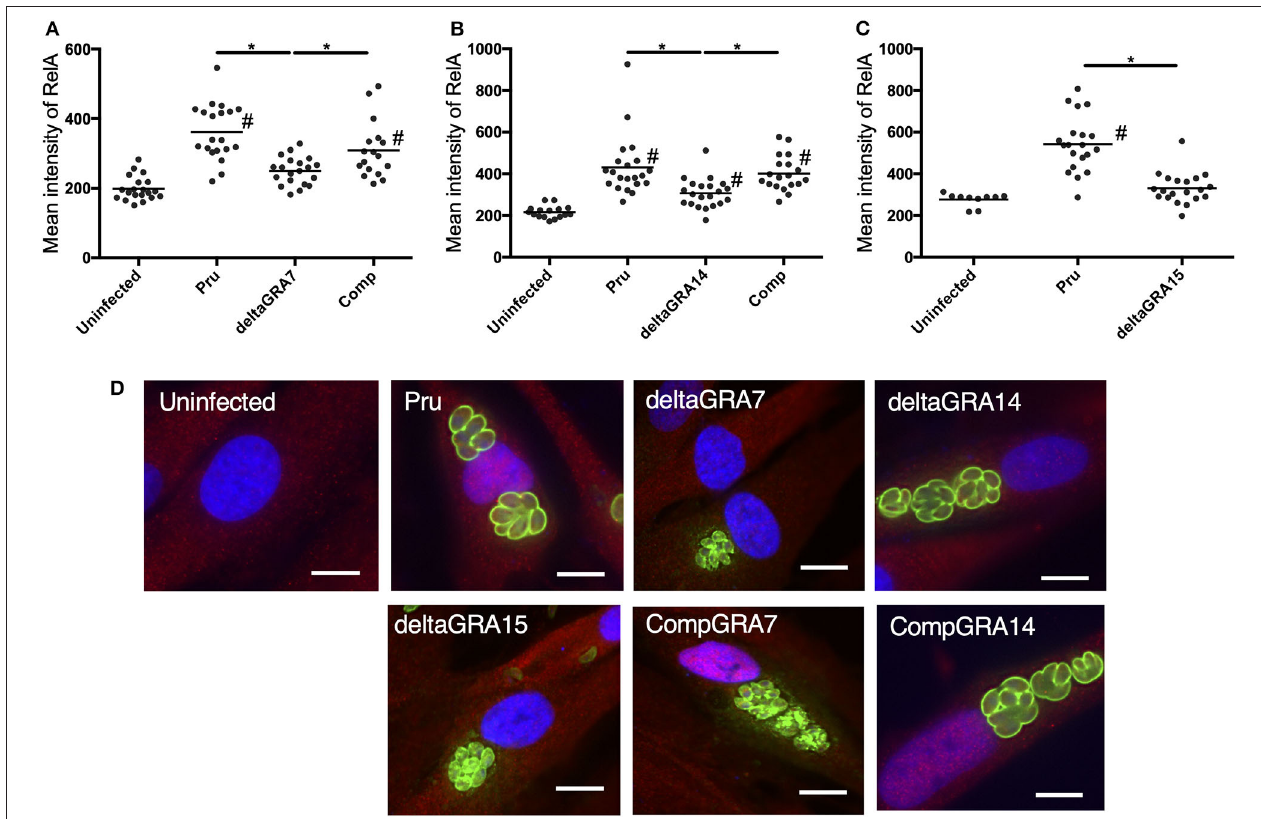
FIGURE 3 | T. gondii infection with parasites deficient in GRA7, 14, or 15 decreases nuclear translocation of NF κ B RelA in HFF cells. (A–C) The mean intensity of RelA in the nucleus was measured in HFF cells for each group. Experiments were performed twice. Bar indicates the mean of each group, * p < 0.05. #a significantly higher level of nuclear RelA compared with uninfected cells ( p < 0.05). Differences were tested by one-way ANOVA with turkey’s post-hoc test. (D) Representative IFAT images of HFF cells infected with parasite strains and uninfected control cells. After infection for 24h, cells were fixed and stained with α -NF κ B RelA (red), α -SAG1 (green), and Hoechst dye (blue). Bars, 10 µ